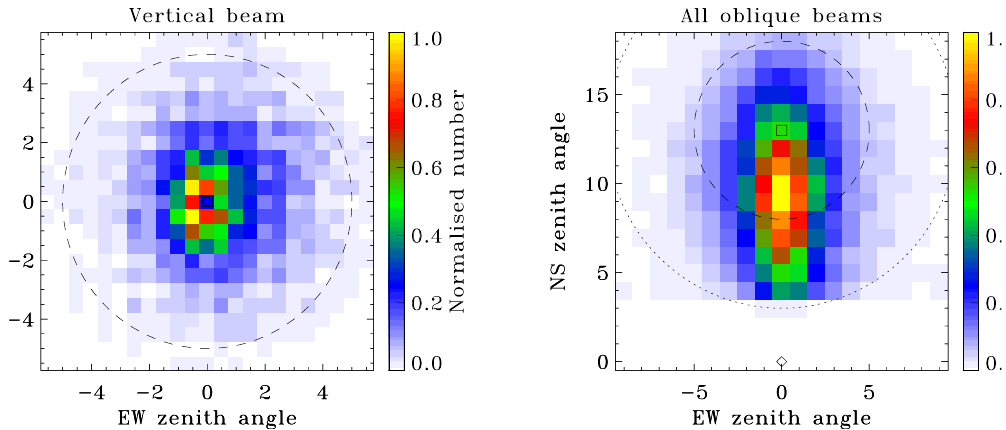
Fig. 7. Histograms of effective beam positions estimated during the 5-beam Doppler campaign July 1998. The left plot shows vertical beam, while the right plot shows the combined results from the north, east, south and west beam directions, with the east, south and west beams results rotated to the north. The squares indicates the beam direction, and the diamonds indicates the zenith.